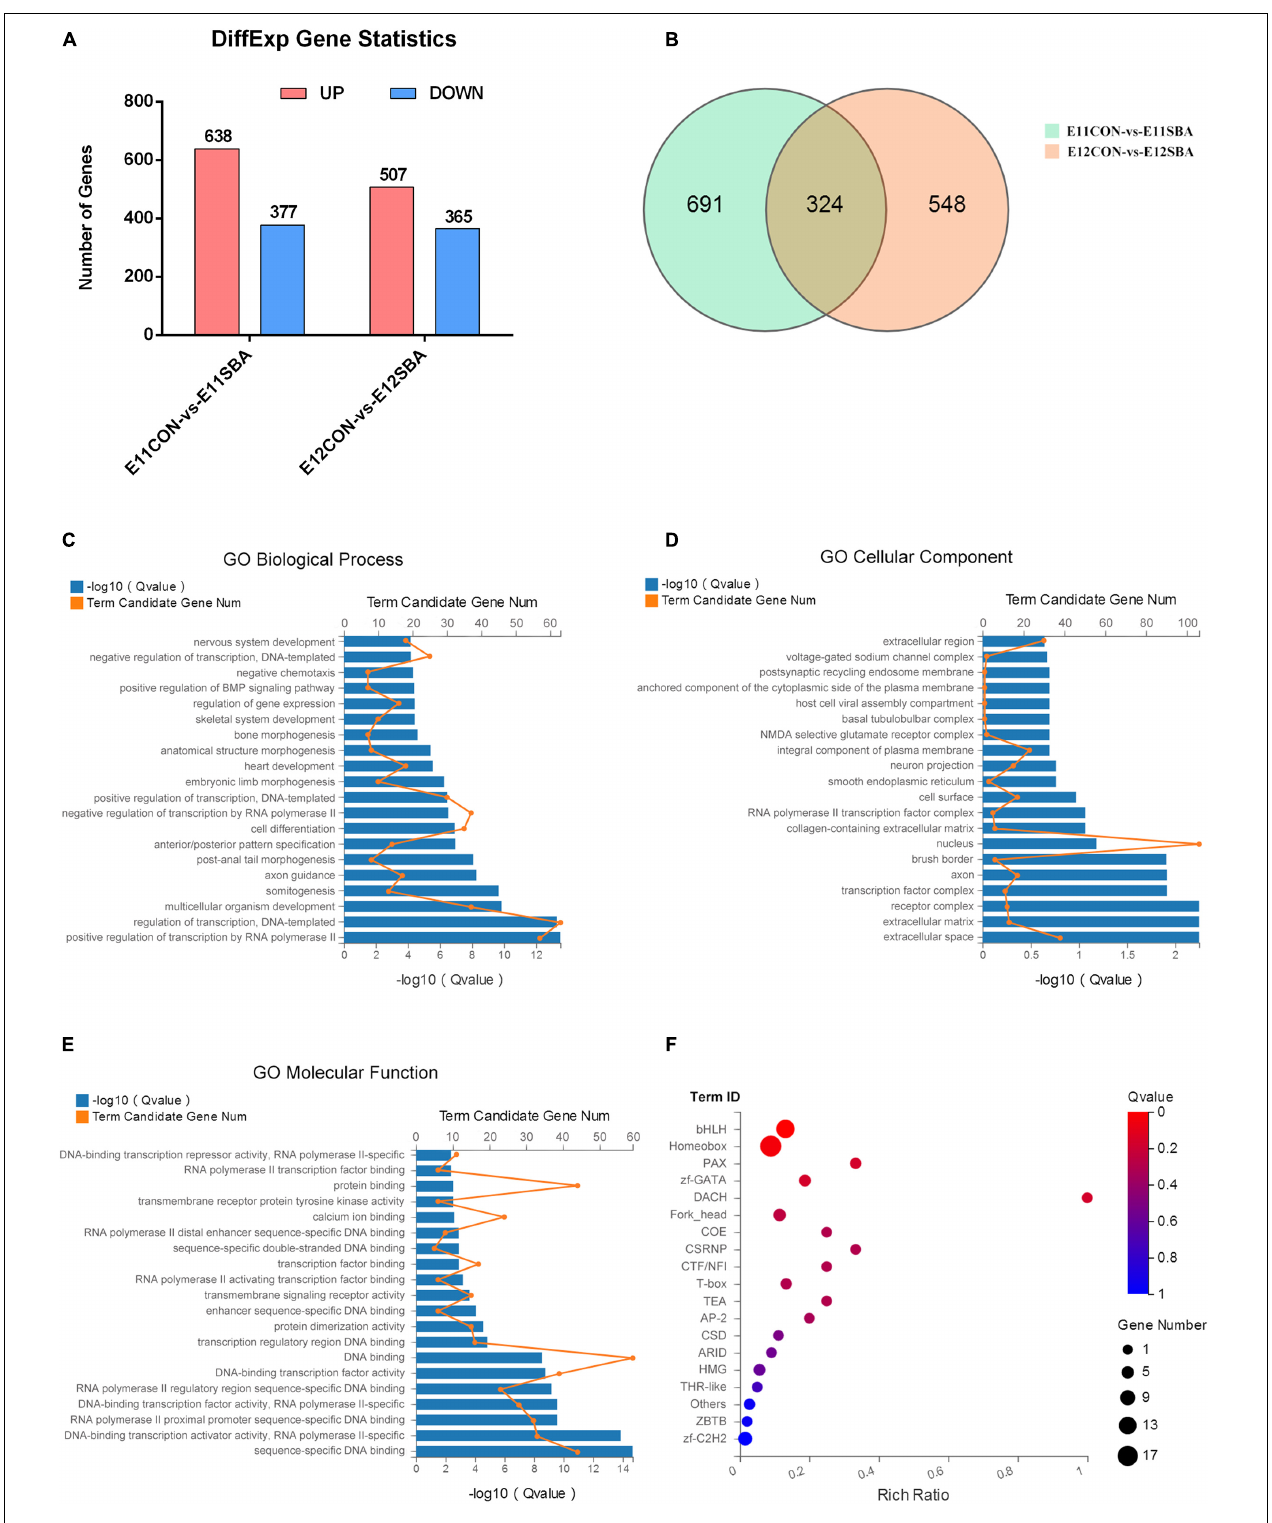
FIGURE 4 | Transcriptome alterations in the ATRA-induced SBA rat model (E11 and E12). (A) Number of DEGs between SBA and CON rat embryos on E11 and E12. DESeq2 | log 2 FC| ≥ 0.3, Q ≤ 0.05. (B) Venn diagram of DEGs in E11CON vs. E11SBA and E12CON vs. E12SBA. (C) Top 20 enriched BP terms in GO analysis. (D) Top 20 enriched CC terms in GO analysis. (E) Top 20 enriched MF terms in GO analysis. (F) Transcription factor enrichment analysis of DEGs. Terms were considered significantly enriched when Q ≤ 0.05.